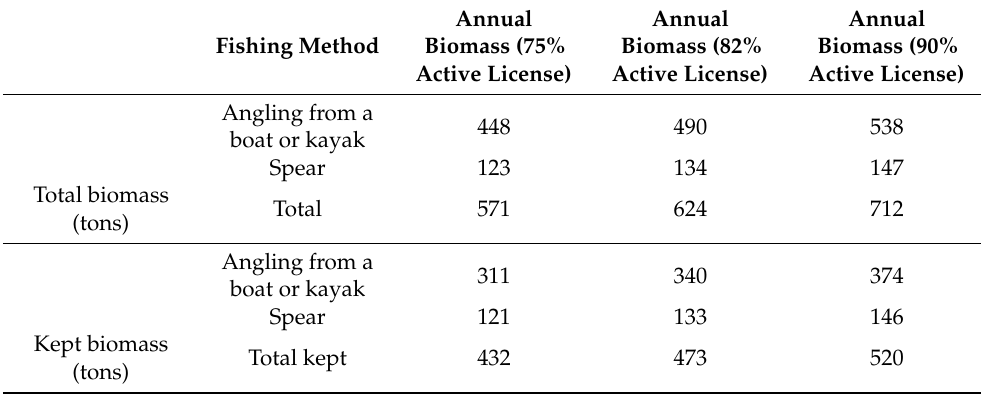
Table 2. Estimated annual total and kept biomass (tons) for recreational fishing at sea using. Estimates are based on the number of registered fishers.